Question: Provide a one-line summary of what is displayed.
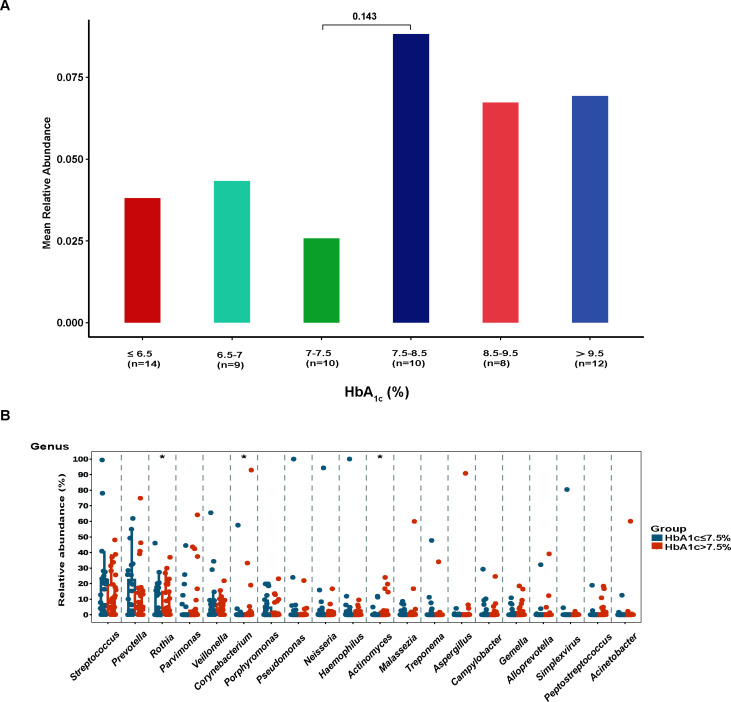
Answer: Parvimonas dysbiosis shows no significant association with HbA1c levels in the LRTI with DM group. ( A ) Patients were stratified into six subgroups based on HbA1c levels. No significant differences in Parvimonas abundance were observed across the subgroups. ( B ) Comparison of differences in relative abundance of microbial communities between groups (HbA1c ≤7.5% vs >7.5%) at genus levels. * P < 0.05.